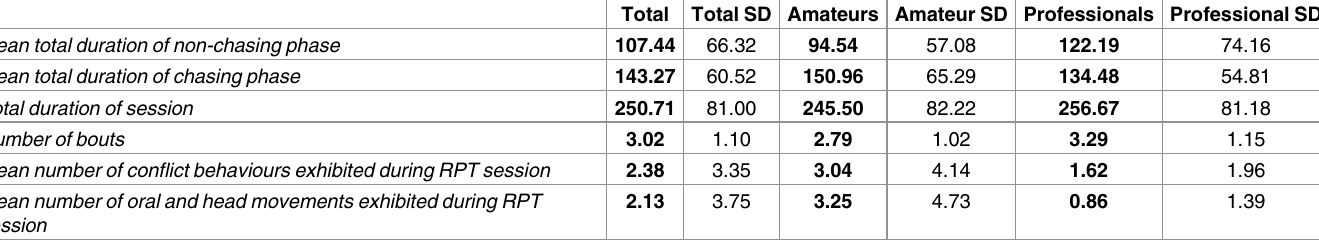
Table 3. Descriptivestatistics (mean and standard deviation for both professional and amateur trainers) of typical RPT sessions from a study of online videos (n =